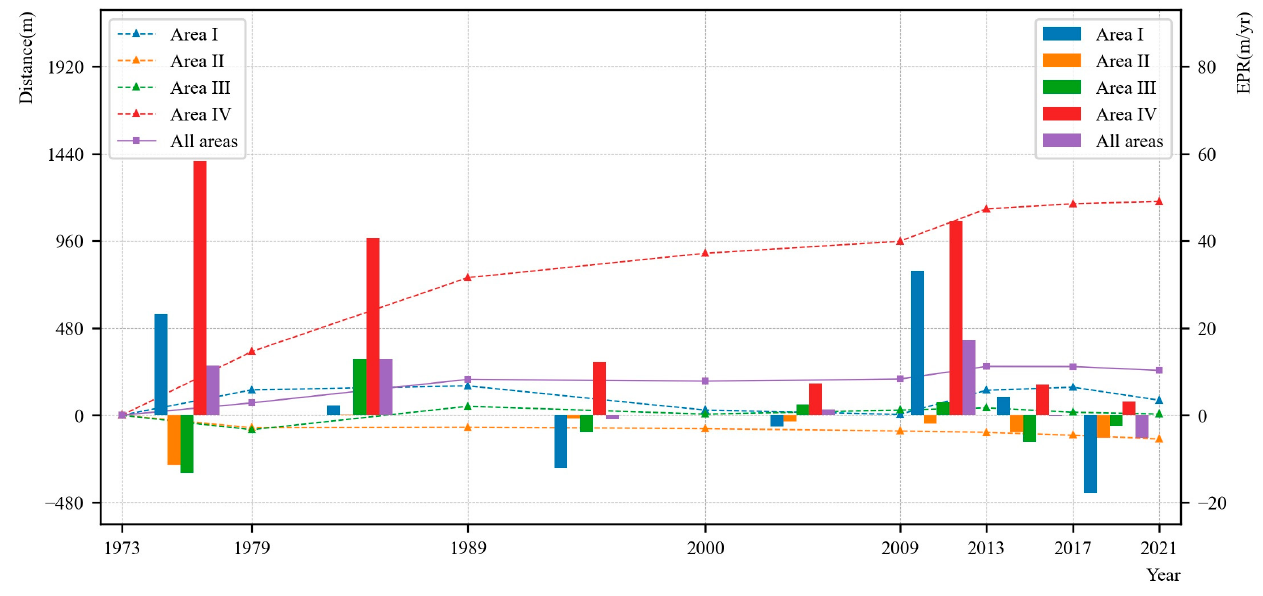
Figure 7. Coastline change distance and the End Point Rate (EPR) for Area I, Area II, Area III, Area IV, and the whole region.